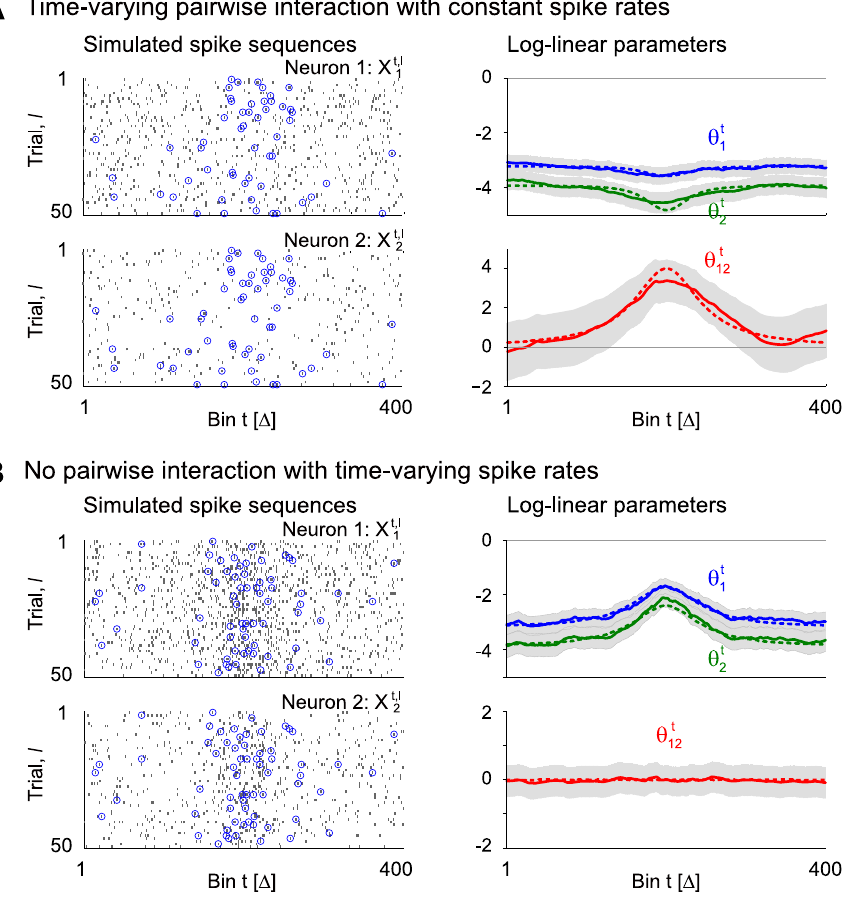
Figure 2. Estimation of pairwise interactions in two simulated parallel spike sequences. (A) Application of the state-space log-linear model to parallel spike sequences with time-varying spike interaction. (Left) Based on a time-dependent formulation of the log-linear model (dashed lines in the right panels represent the model parameters), N ~ 2 parallel spike sequences, X t , l , are simulated repeatedly for n ~ 50 trials (duration: T ~ 400 bins). The two panels show dot displays of the spike events of the variables, X t , l or X t , l ( t ~ 1, ... , T and l ~ 1, ... , n ). The observed 1 2 synchronous spike events across the two spike sequences within the same trials are marked by blue circles. (Right) Smoothed estimates of the log- linear parameters, h t (solid lines, red: pairwise interaction; blue and green: the first order), estimated from the data shown in the left panels. The gray bands indicate the 99% credible interval from the posterior density of the log-linear parameters. The dashed lines are the underlying time-dependent model parameters used for the generation of the spike sequences in the left panels. (B) Application of the state-space log-linear model to independent parallel spike sequences with time-varying spike rates. Each panel retains the same presentation format as in A. trials. Figure 4C displays the MAP estimates (solid lines) of the log- linear parameters from the data shown in Figure 4A. Here, non- zero parameter h t represents a triple-wise spike correlation, i.e., 123 excess synchronous spikes across the three neurons or absence of such synchrony compared to the expectation if assuming pairwise correlations. The gray band is the 99% credible interval from the marginal posterior density, p h t j y 1 : T , w (cid:6) (cid:7) , for I [ V 1 , V 2 , V 3 f g . I